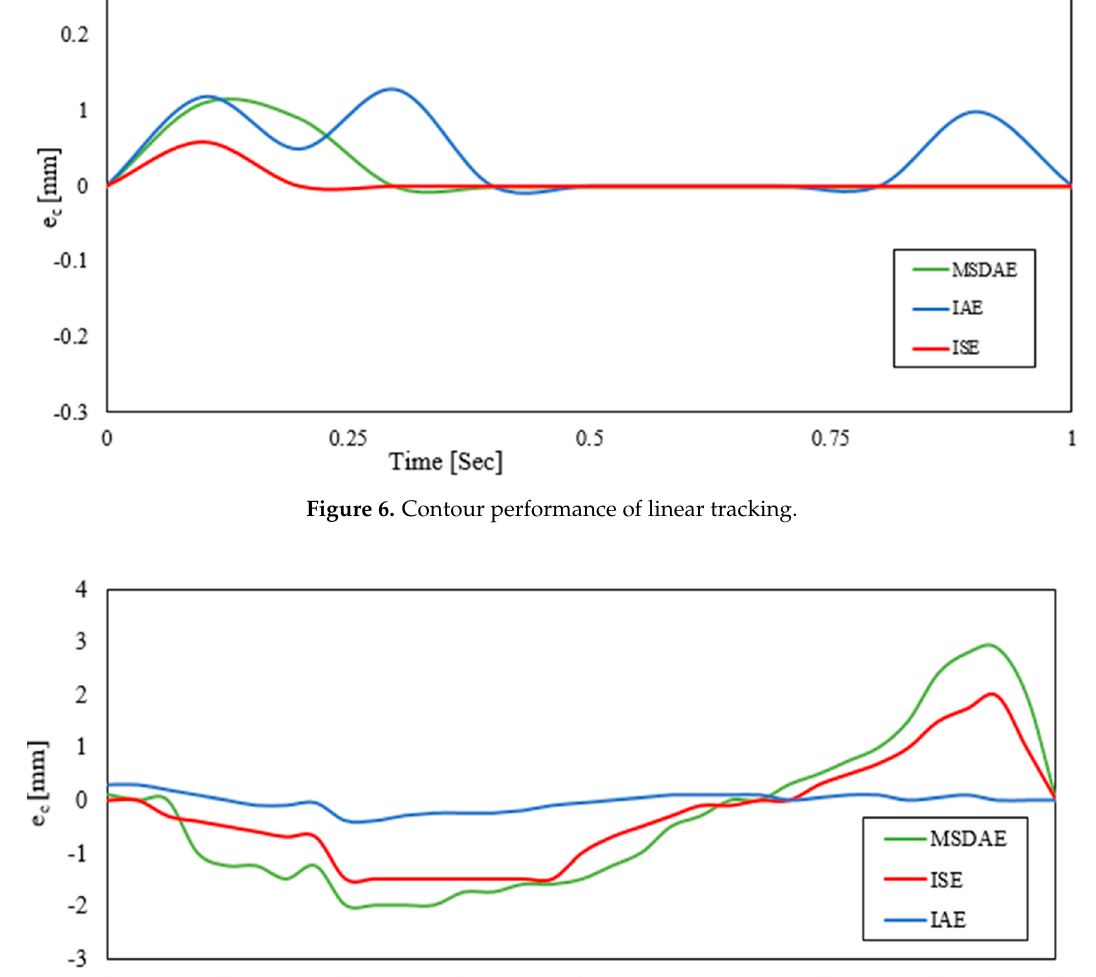
Figure 7. Contour performance of non-linear tracking.